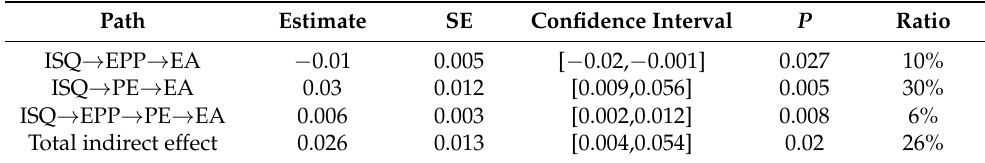
Table 5. The results of the mediating effect test.